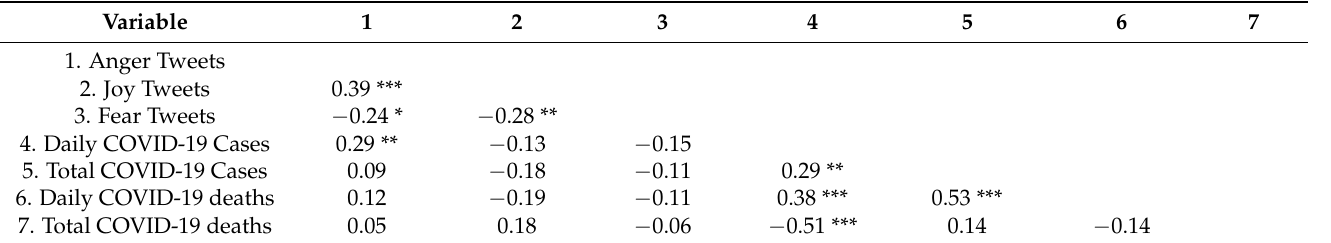
Table A10. Cagliari Pearson’s correlation coefficient